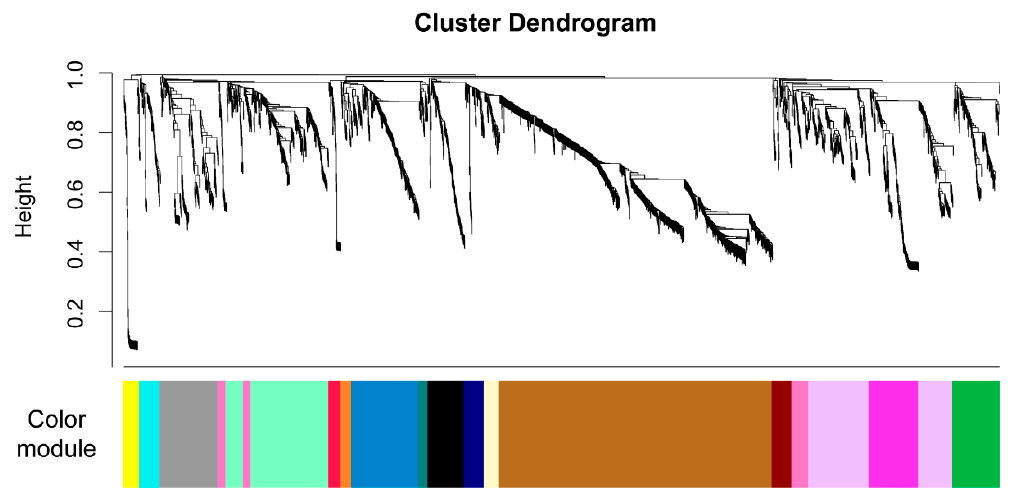
Figure 5. WGCNA analysis was used to group the mzRT features from the untargeted metabolomics data into modules. The figure shows the results from clustering 2858 mzRT features, and the color bar on the bottom indicates the arbitrary colors assigned to each module.